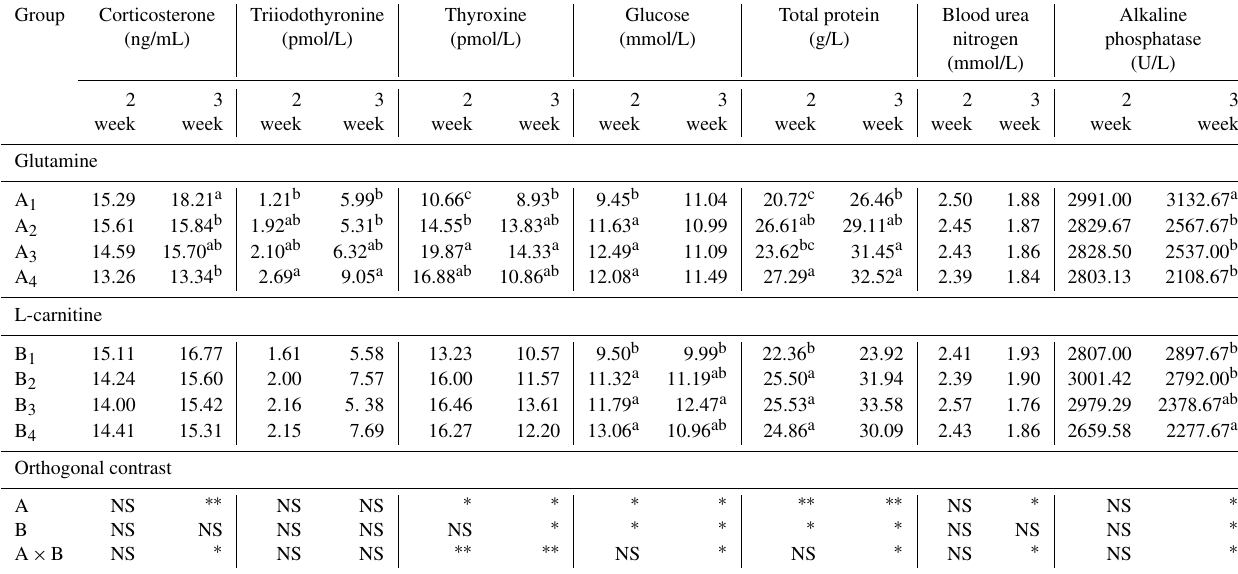
Table 7. The effects of supplemented glutamine and L-carnitine on corticosterone, thyroid hormone and other parameters of Arbor Acres broilers under low temperature